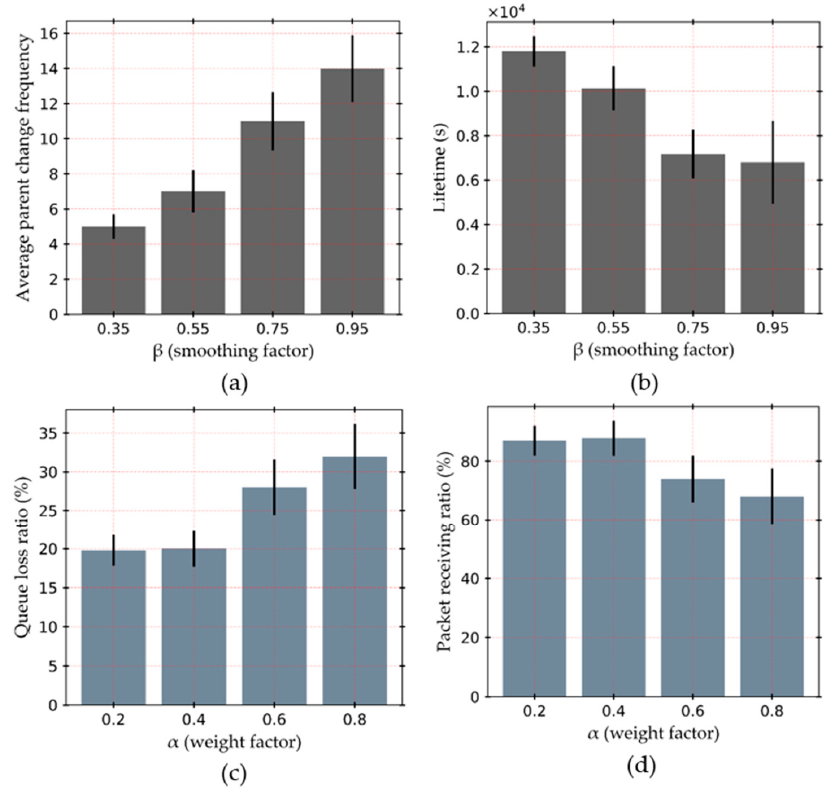
Figure 16. The effect of the design parameters on performance; ( a ) average parent change frequency with varying smoothing factor β , ( b ) lifetime in seconds with varying β , ( c ) queue loss ratio with varying weight factor α , and ( d ) packet receiving ratio with varying α .